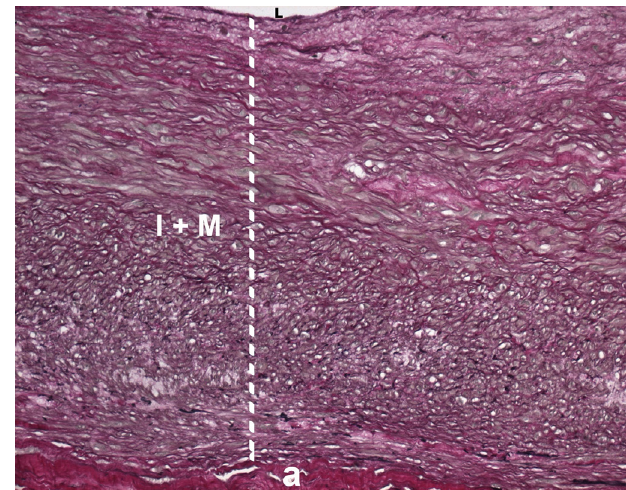
Fig. 3 - Photomicrograph of right coronary artery with sequelae of arteritis. Destruction of the elastic laminae (black color). a=coronary adventitia; I + M=intimal and medial layers; L=coronary lumen